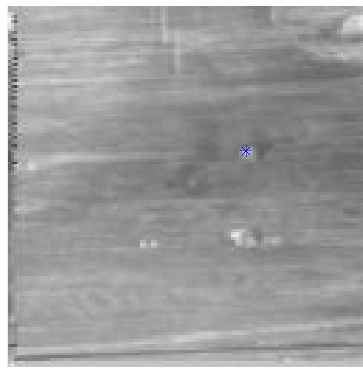
Figure 2. One of the real infrared (IR) images for